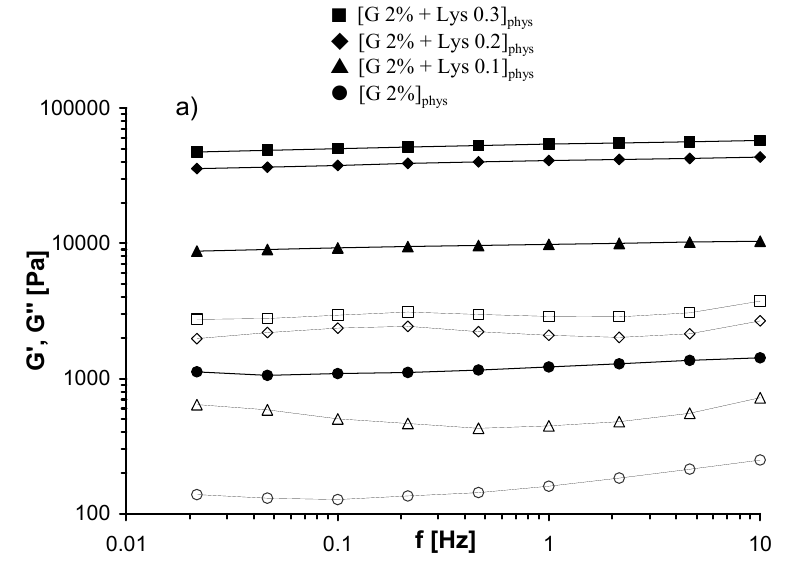
Figure 3. Frequency Sweep of Gellan physical gels, performed at 25 °C (a) and 37 °C (b). G’ (filled symbols), G’’ (empty symbols) (in the legend G = Gellan).